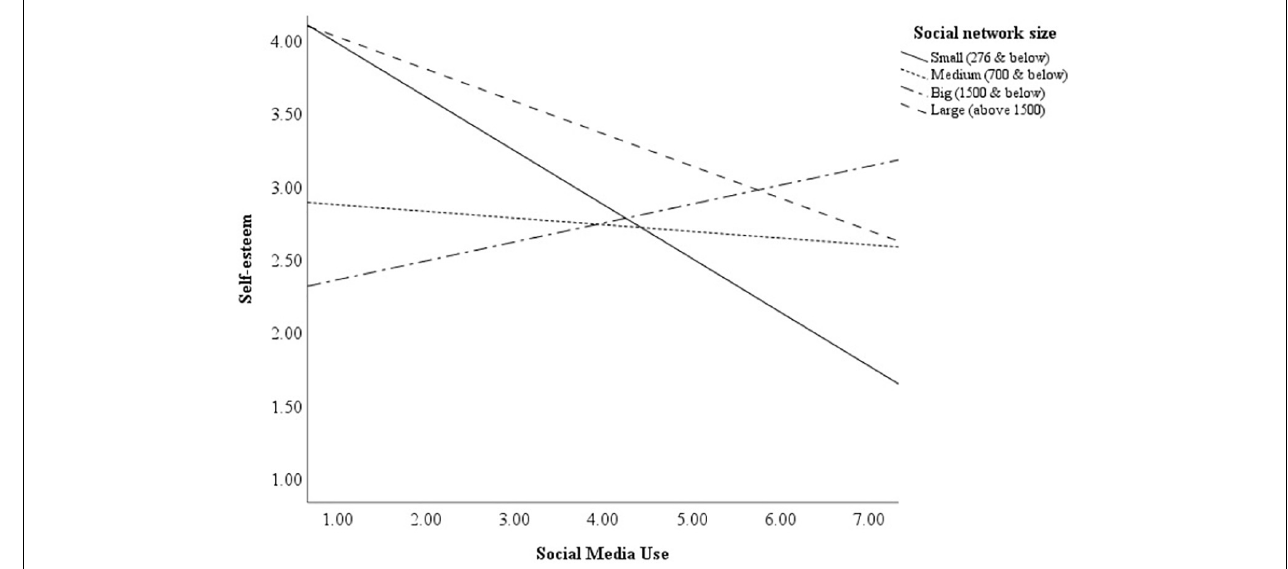
FIGURE 1 | Moderation of social network size on social media use and self-esteem ( N =